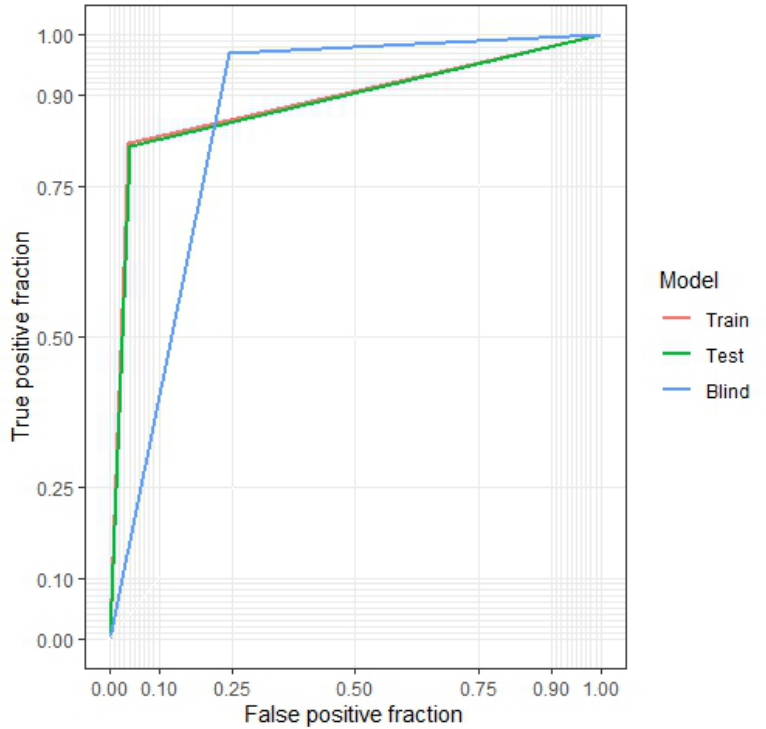
Figure 7. Performance of the model measured using receiver operating characteristic (ROC) curves, red line = train data set, green line = test data set, blue line = blind data set.